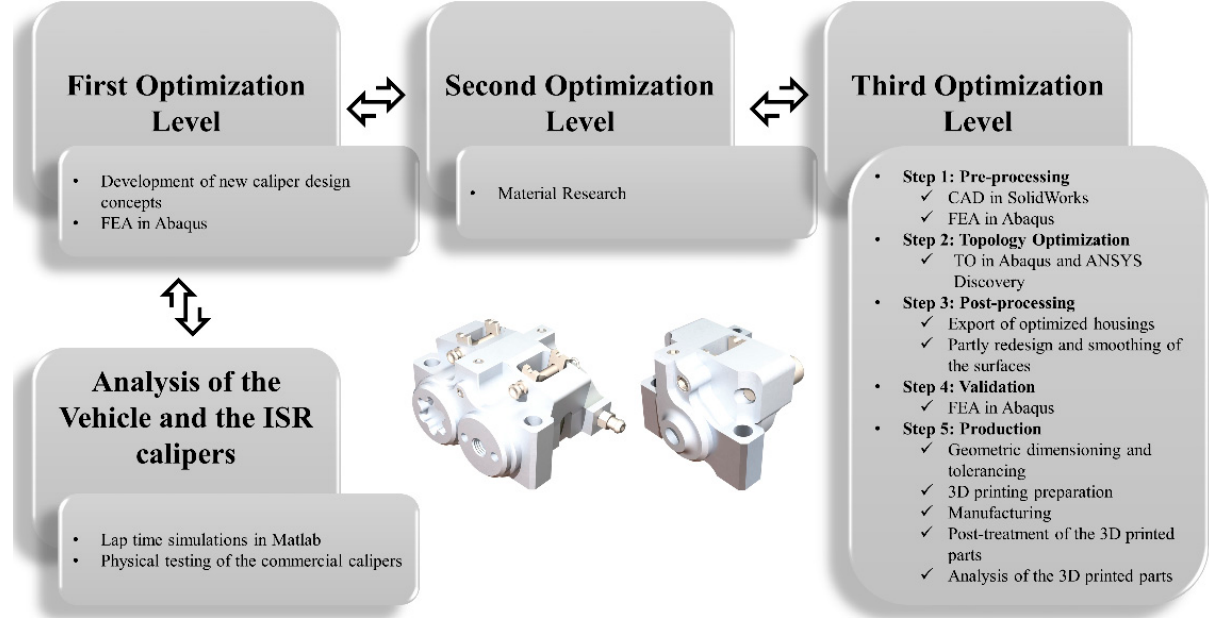
Figure 5. The optimization procedure.